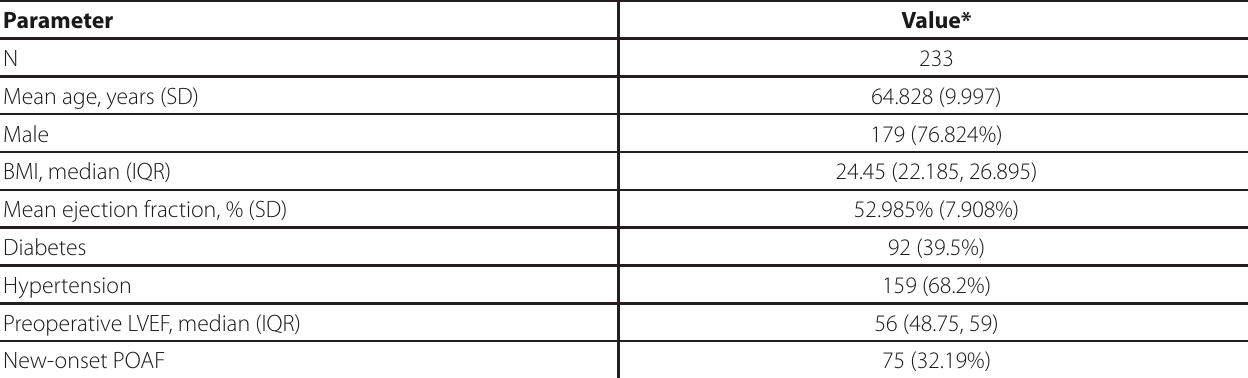
Fig. 2 - Day of initial occurrence for new-onset postoperative atrial fibrillation. The denominators are 75 patients for new-onset postoperative atrial Table 1 . Cohort characteristics.